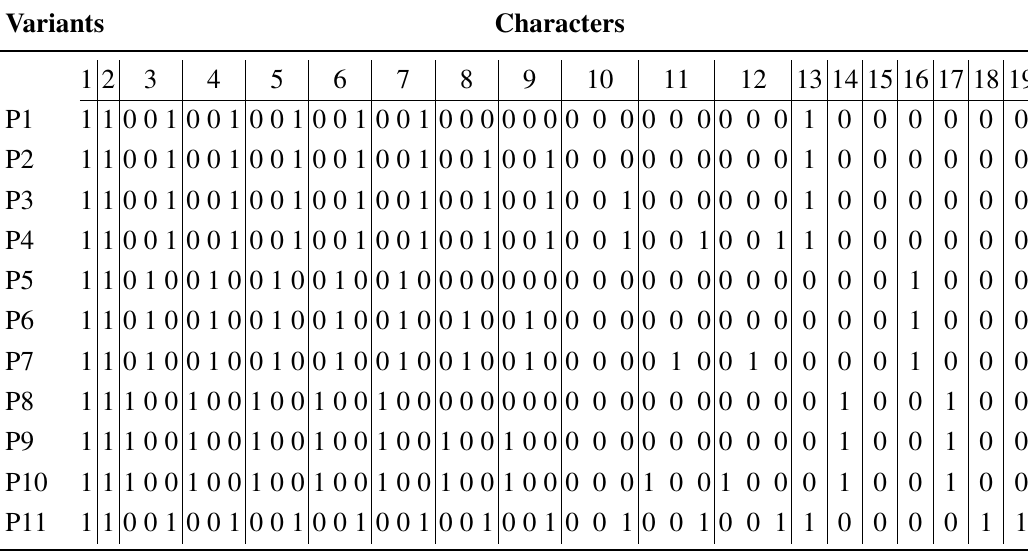
Table 3. Matrix of characters